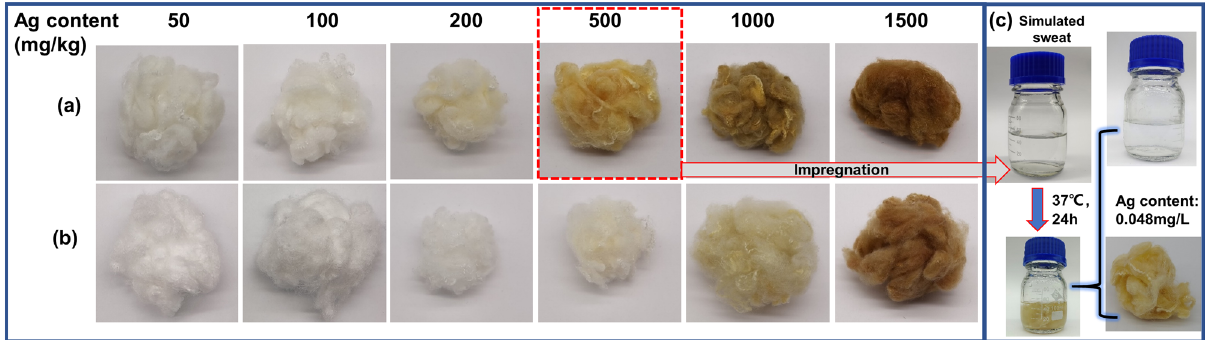
Figure 9: ( a ) Original and ( b ) washed polyester fi bers and ( c ) photos of the process of impregnation of 1 g of AgNP - coated polyesters fi bers in 50 mL of simulated sweat. The detected Ag content by the ICP - MS method in the fi nal impregnation solution was 0.048 mg/L.